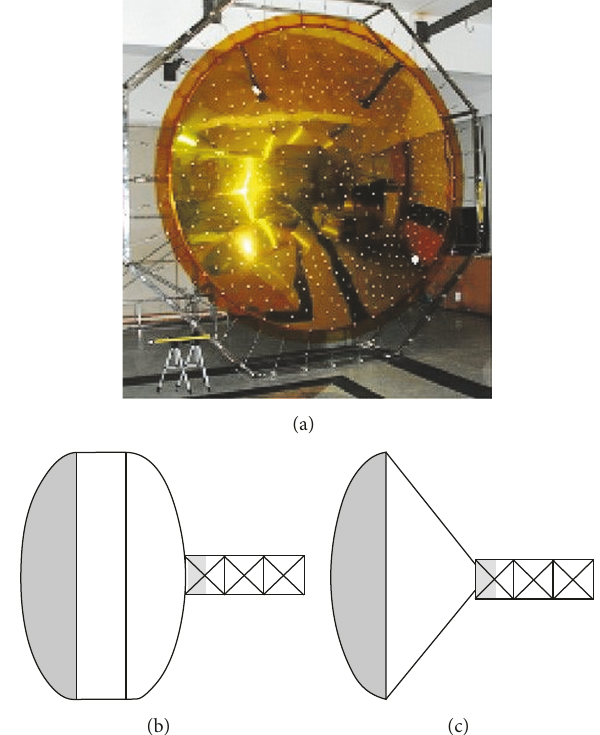
Figure 10: A model of the inflatable antenna proposed in [35,